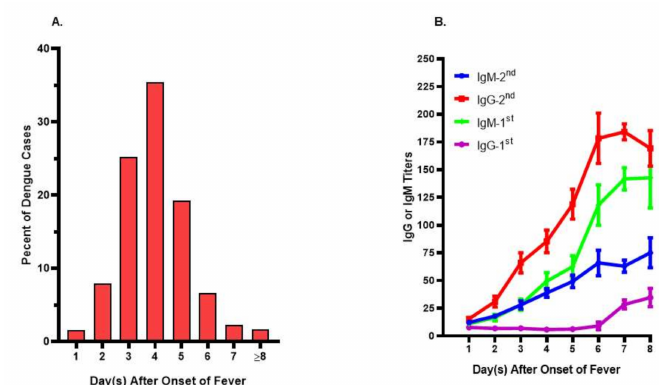
Figure 2. Onset days of f0.9ver and immune profiles in acute dengue patients. ( A ) Onset days of fever in dengue patients seeking professional help. The day of fever onset was recorded based upon the recall from dengue patients upon their visiting to the hospital. Patients whose onset day fever was on or after the 8th day were indicated as ≥ 8. The data were tabulated from more than 1500 dengue patients. ( B ) Immune profiles in patients with primary (1st) or secondary (2nd) DENV infections. The daily IgG or IgM titers during febrile period were measured from sequential specimens collected from 16 primary and 32 secondary dengue patients, respectively. There were low antibody titers during the first couple days of fever in both primary and secondary dengue